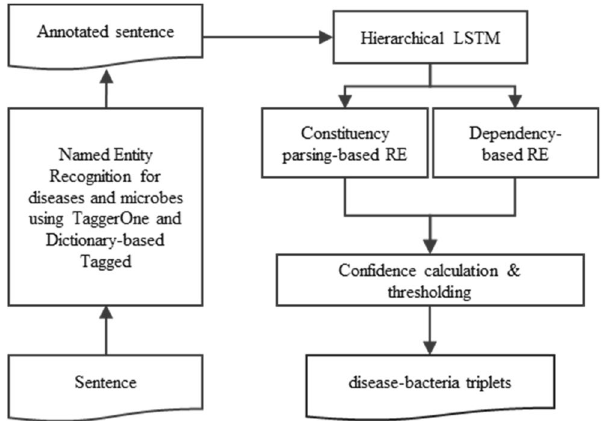
Figure 1. Workflow of extracting the associations between microbes and diseases. The NER process uses two approaches: a semi-Markov model for disease and a dictionary-based method for bacteria, bacterial strain, and virus. Relation is determined using a hierarchical LSTM, and the relation word was extracted by an ensemble model of constituency parsing-based and dependency-based